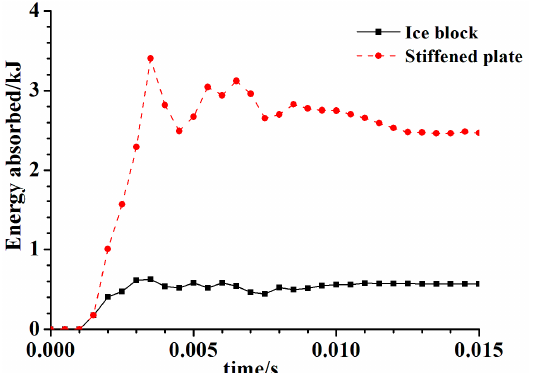
Figure 23. Kinetic energy of the stiffened plate and ice block obtained from simulation.